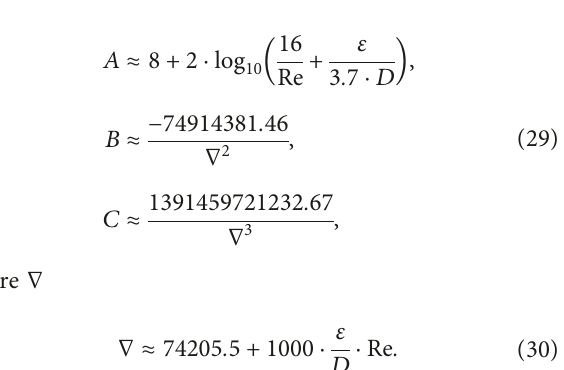
Figure 7: Distribution of the relative error over the domain of applicability of the Colebrook equation of the approximation, Equation (28); for i 0, the maximal relative error is 0.69%. (cid:31)